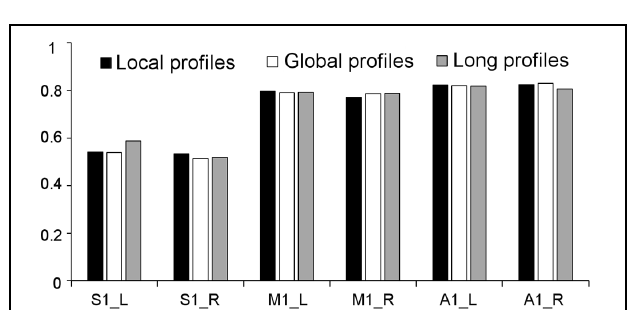
FIGURE 2 | Consistency between the results from dataset 1 using local, global, and long connectivity profiles and the cytoarchitectonic results from the SPM Anatomy